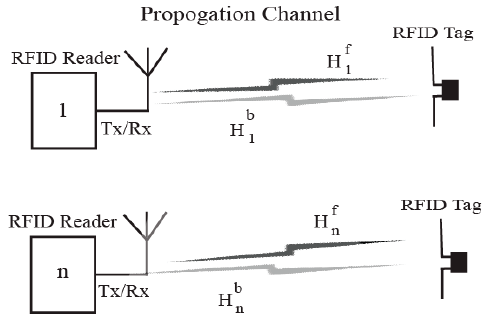
Figure 2. An illustration of multiple-tag RFID system.